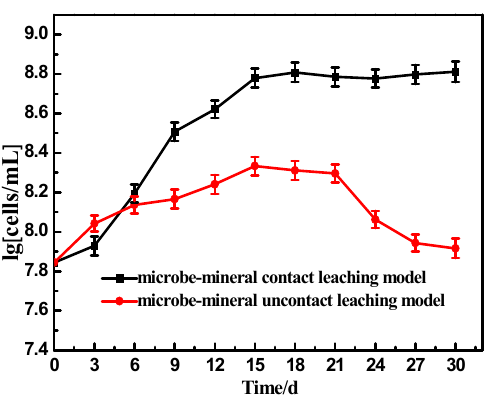
Figure 4. Bacterial concentration changes with bioleaching time.